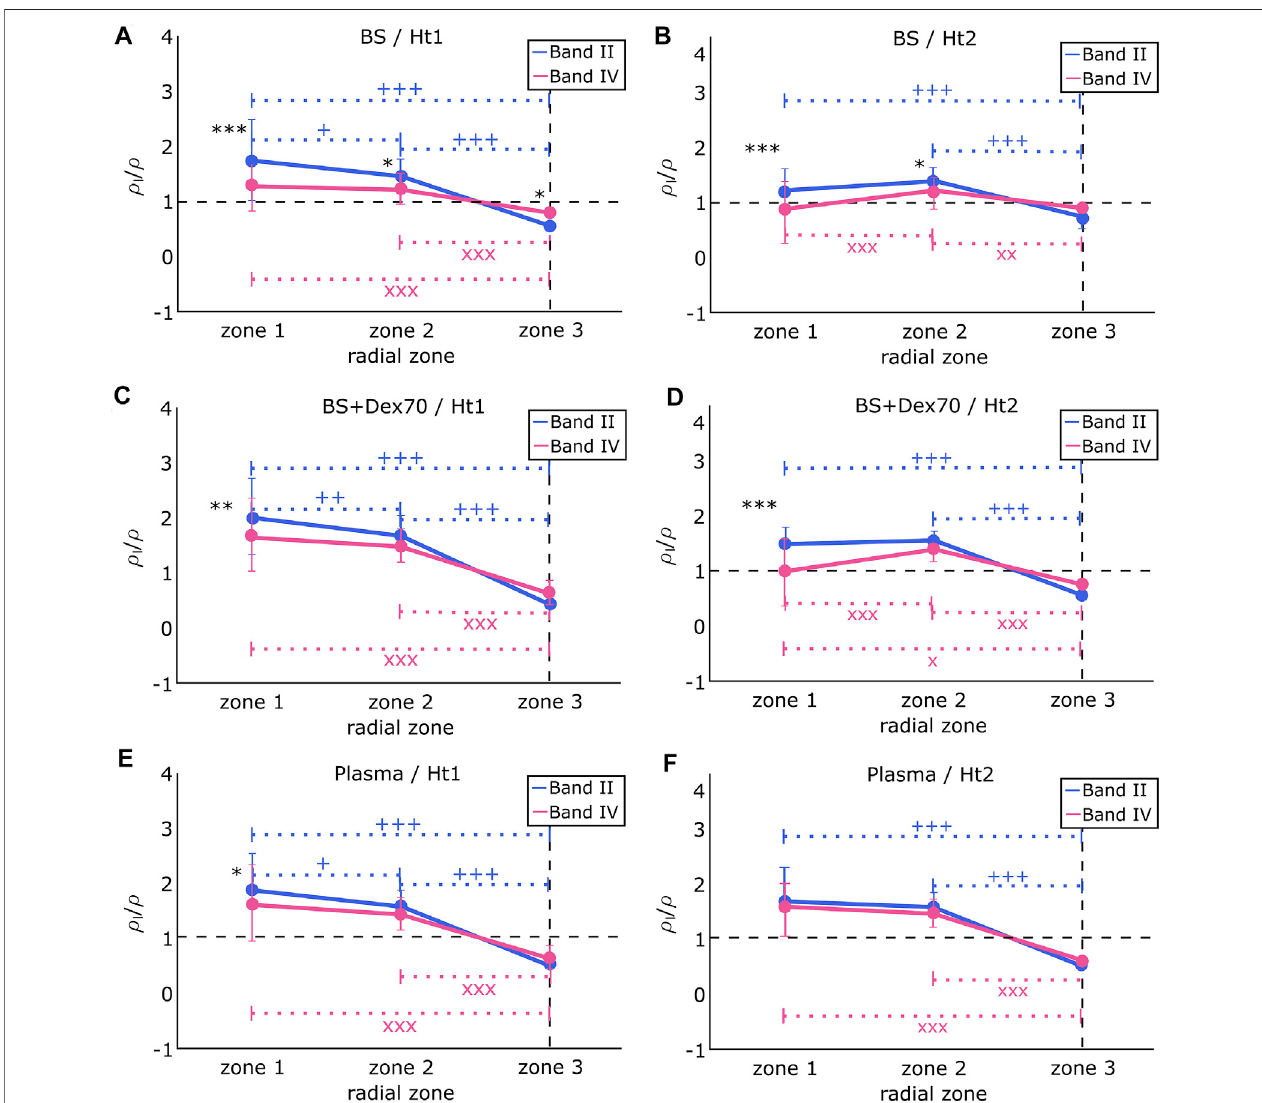
FIGURE 5 | Radial sRBC accumulation ( ρ l / ρ ) from band II and IV in (A) BS and at hematocrit H t1 . Difference between band II and band IV: * p < 0.05; *** p < 0.001. Difference between zones for band II: + p < 0.05; +++ p < 0.001. Difference between zones for band IV: XXX p < 0.001. (B) BS and at hematocrit H t2 . Difference